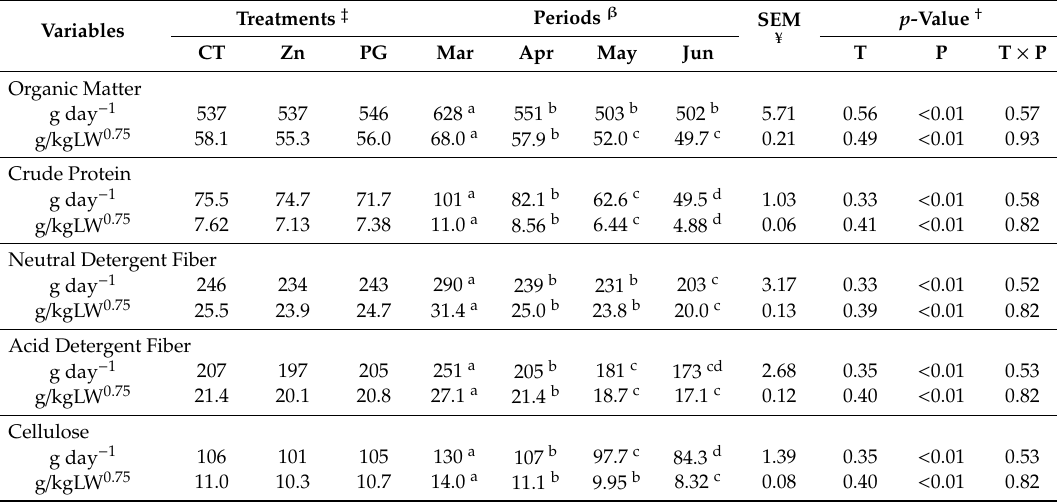
Table 5. E ff ects of zinc or propylene glycol supplementation on nutrient and fibrous fractions intake in sheep on Caatinga -native pasture.